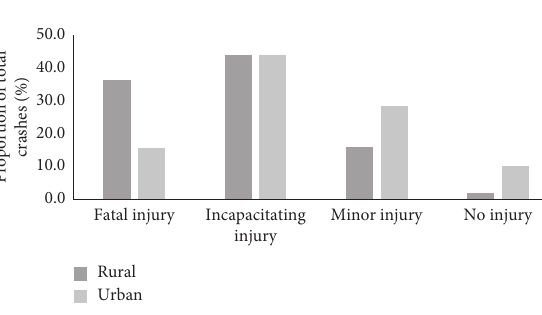
Figure 1: Distribution of motorcycle crash Table 2: Descriptive statistics of variables used in model estimation.